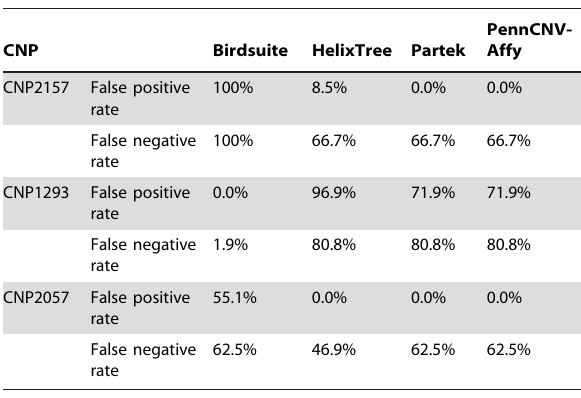
Table 8. qPCR validation of the calls made by each program for three common CNVs identified by Canary in the BiGS